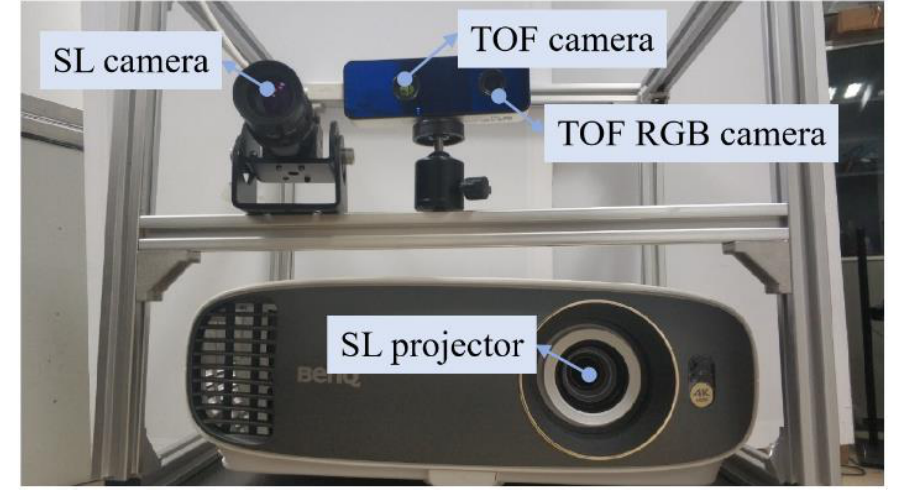
Figure 7. Experimental setup. Table 1. Calibration results.